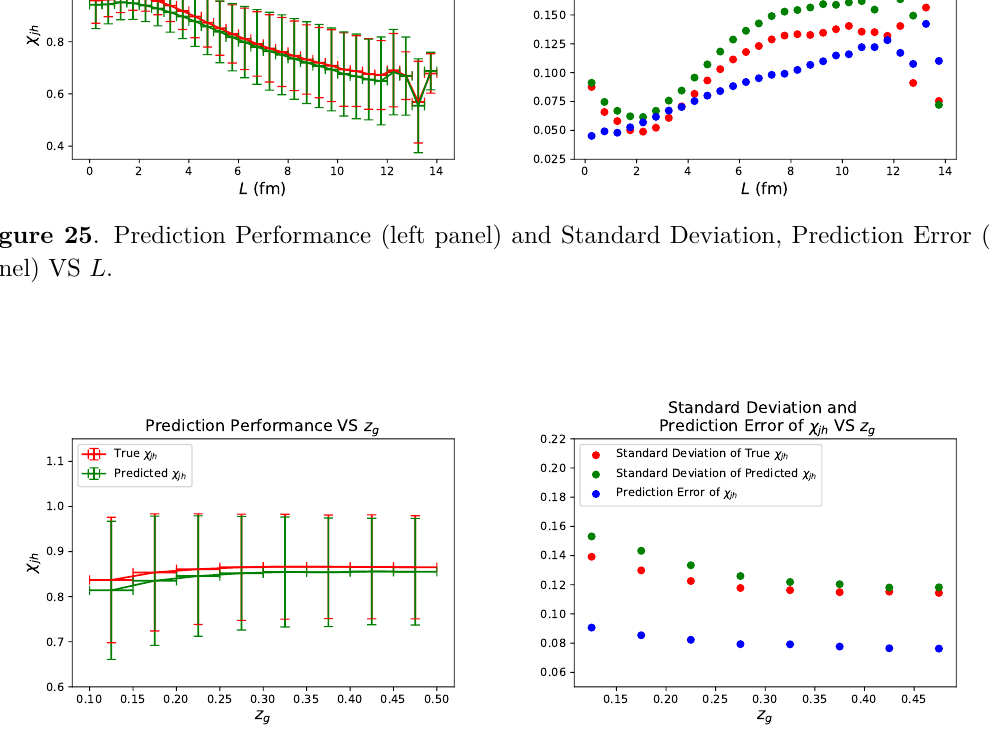
Figure 26 . Prediction Performance (left panel) and Standard Deviation, Prediction Error (right panel) VS z . g